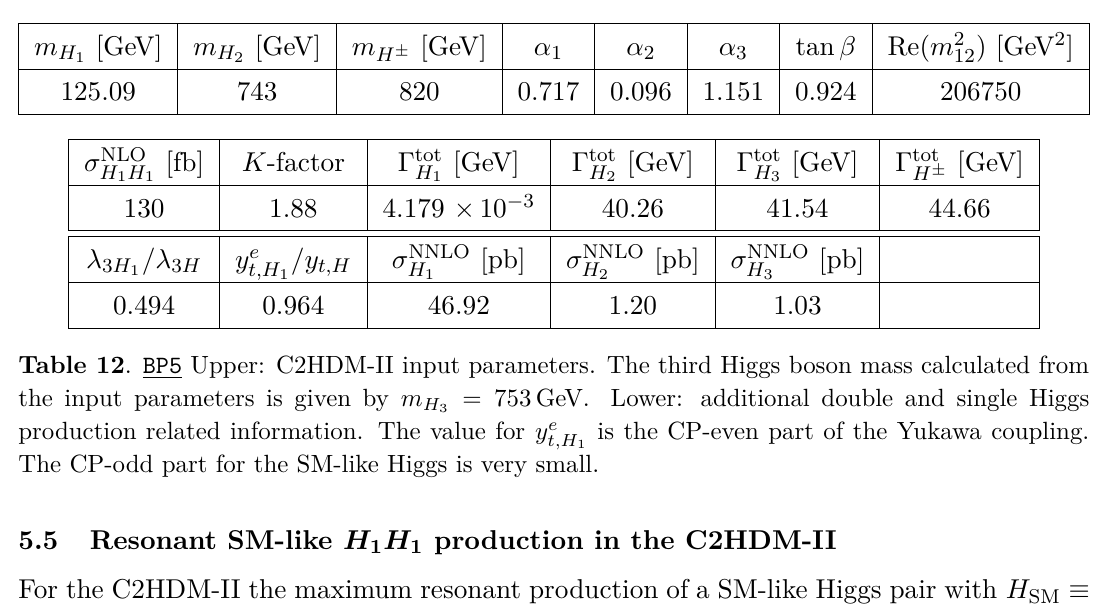
Table 11 . BP4 Upper: C2HDM-I input parameters. The third Higgs boson mass calculated from the input parameters is given by m = 338 GeV. Lower: additional double and single Higgs H 3 production related information. The value for y e is the CP-even part of the Yukawa coupling. t,H 2 The CP-odd part for the SM-like Higgs is tiny.